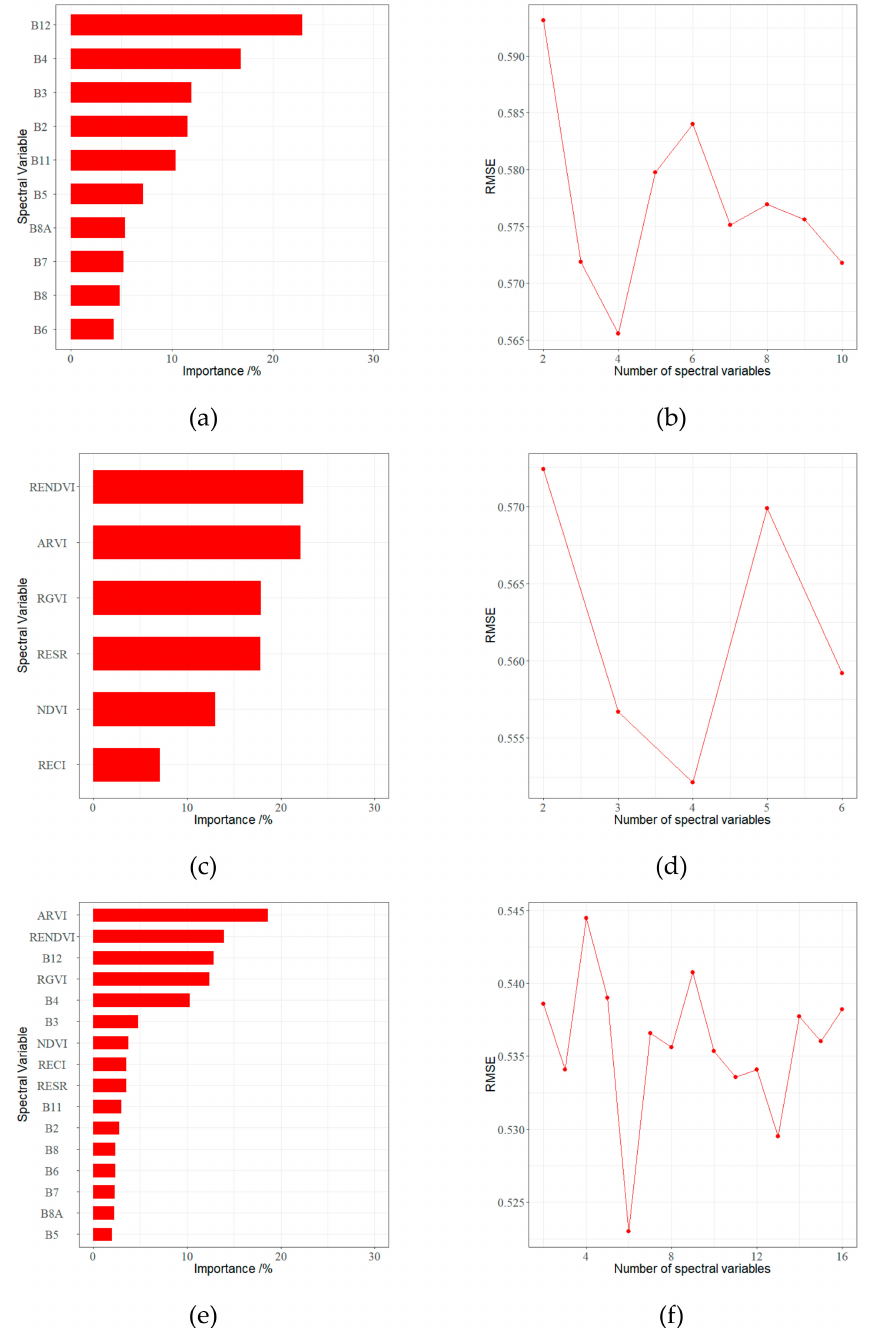
Figure 2. The importance rank of spectral variables for three set inputs of predictors and the root mean square error (RMSE) values of the random forest (RF) method with di ff erent numbers of spectral variables in Ganzhou: ( a ) Importance ranking for input 1 of original spectral reflectance bands and ( b ) RMSE for input 1; ( c ) importance ranking for input 2 of vegetation indices and ( d ) RMSE for input 2; and ( e ) importance ranking for input 3 of combining the original spectral bands and vegetation indices and ( f ) RMSE for input